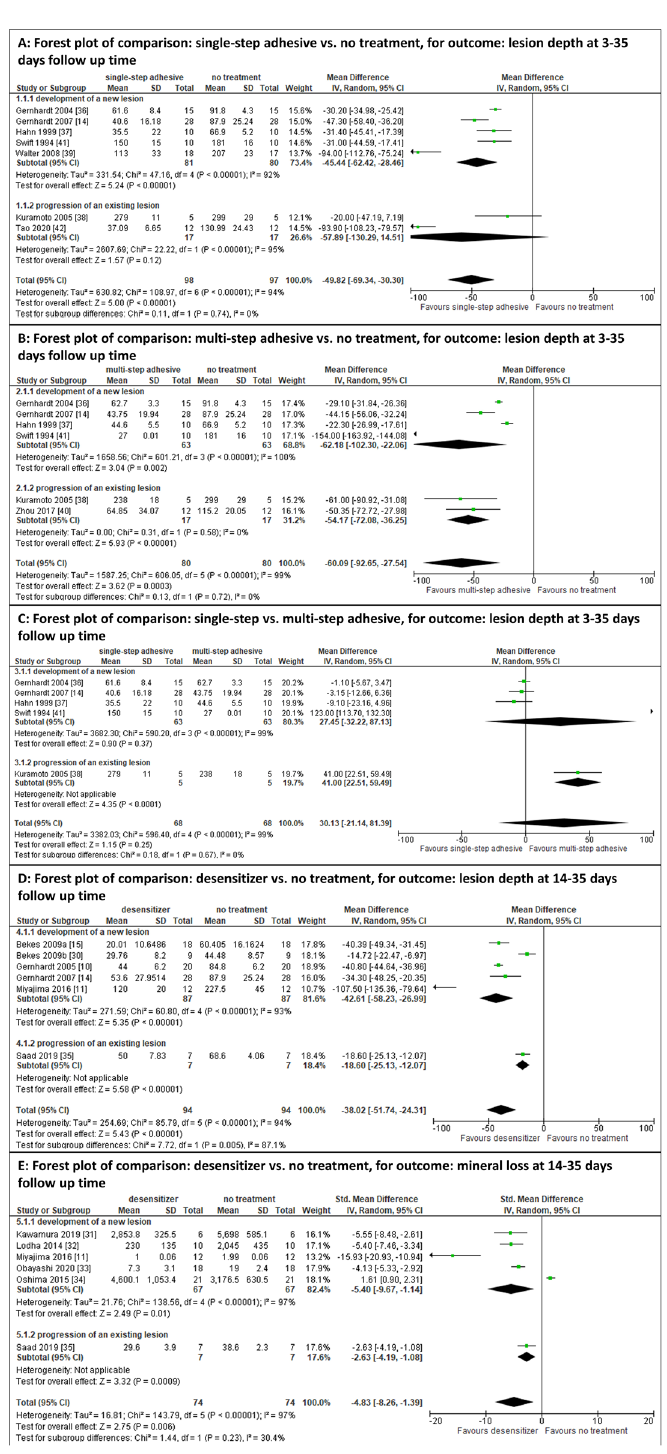
Figure 2. Quantitative meta-analyses for increase of the lesion depth comparing ( A ) single-step adhesives versus untreated control, ( B ) multi-step adhesives versus untreated control, ( C ) single-step versus multi-step adhesives ( D ) desensitizer versus untreated control; and ( E ) same as D, but for outcome. For each comparison MD, 95% CI, forest plots, heterogeneity parameter (I 2 ) as well as overall statistics (Z, P) are